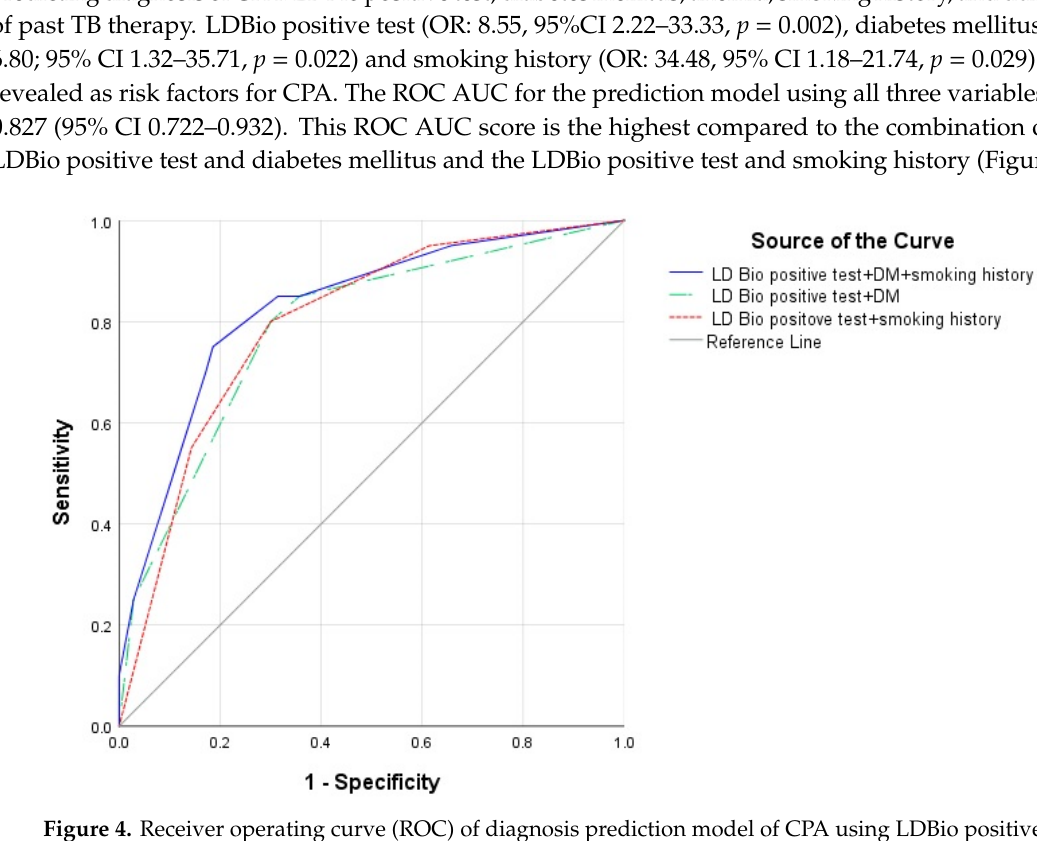
Figure 4. Receiver operating curve (ROC) of diagnosis prediction model of CPA using LDBio positive test + diabetes mellitus (DM) + smoking history (area under curve (AUC) 0.827, 95% CI 0.722–0.932), LD Bio positive test + DM (AUC 0.788, 95% CI 0.673–0.903) and LD Bio positive test + smoking history (AUC 0.796, 95% CI 0.690–0.903).